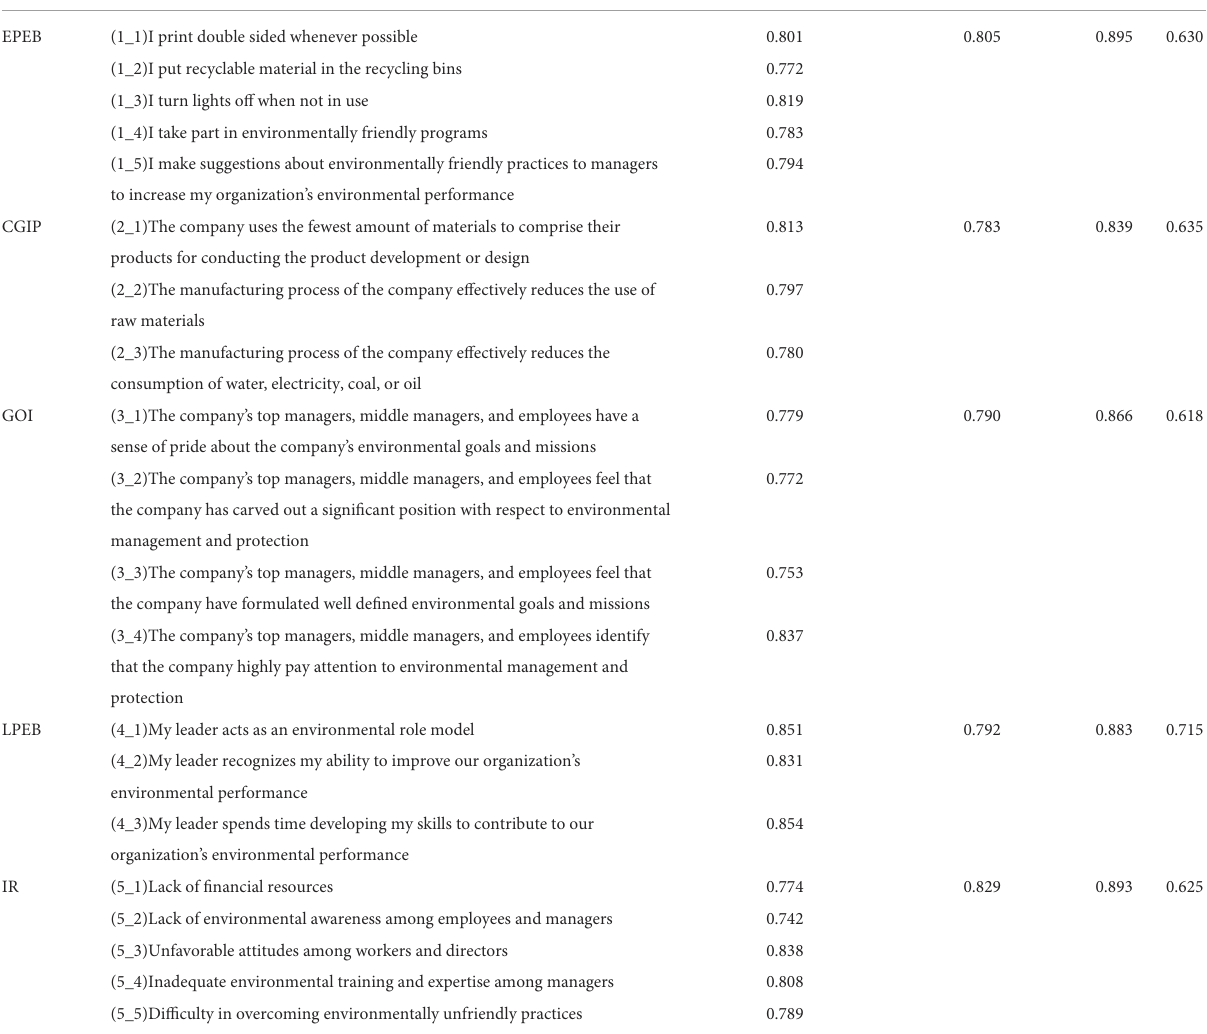
TABLE 1 Research on constructs, measurements, item loadings, and validities.